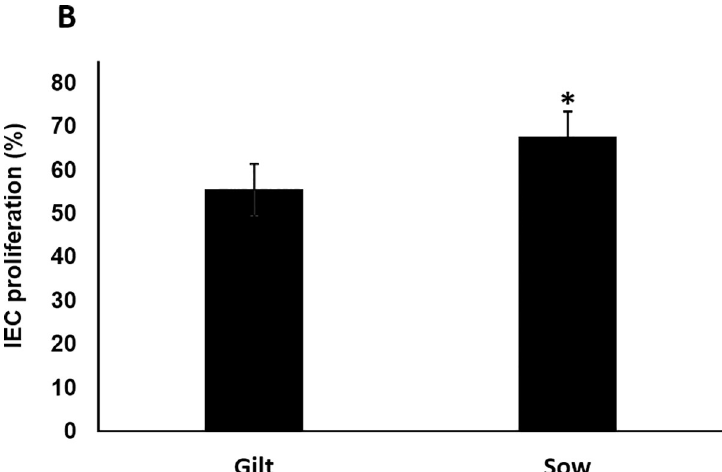
Fig 5. Mitogenic activity of colostrum from gilt and sow on intestinal epithelial cells (IEC-6). Data are expressed as the mean ( ± SEM) percentage of cell viability calculated in relation to untreated cells (negative control). Gilt (55.45 ± 9.74) vs. Sow (67.47 ± 6.76), � p < 0.001.